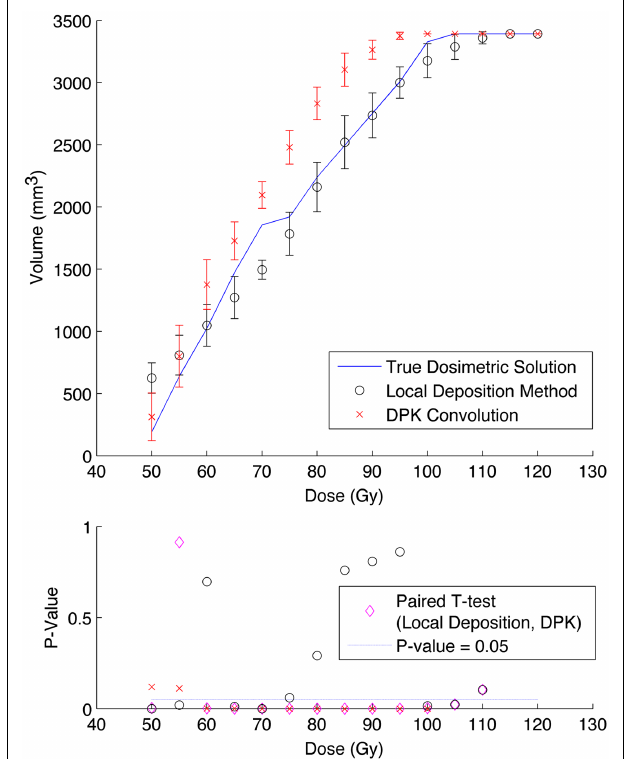
Table 3 | 90 Y dosimetry using PET/CT and the local deposition method .